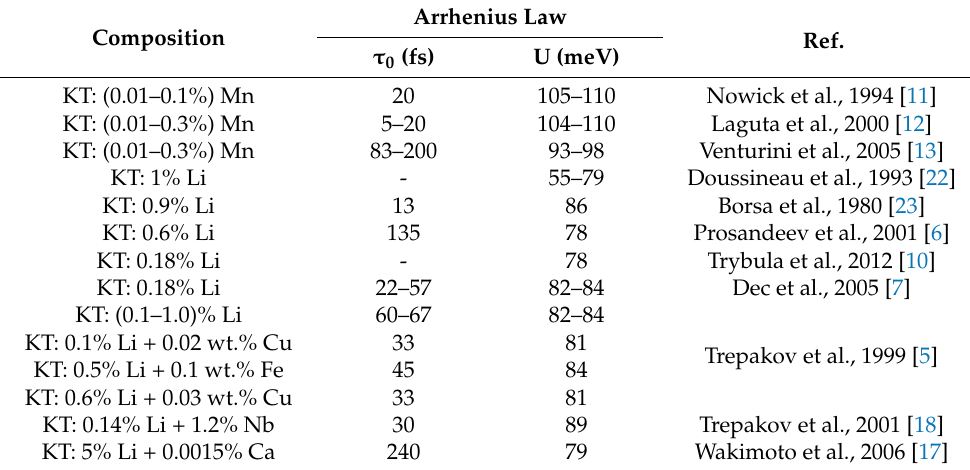
Table 2. Arrhenius law parameters for the dielectric relaxation dynamics in weakly ( ≤ 1%) Li- or Mn-doped as well as co-doped KTaO 3 single